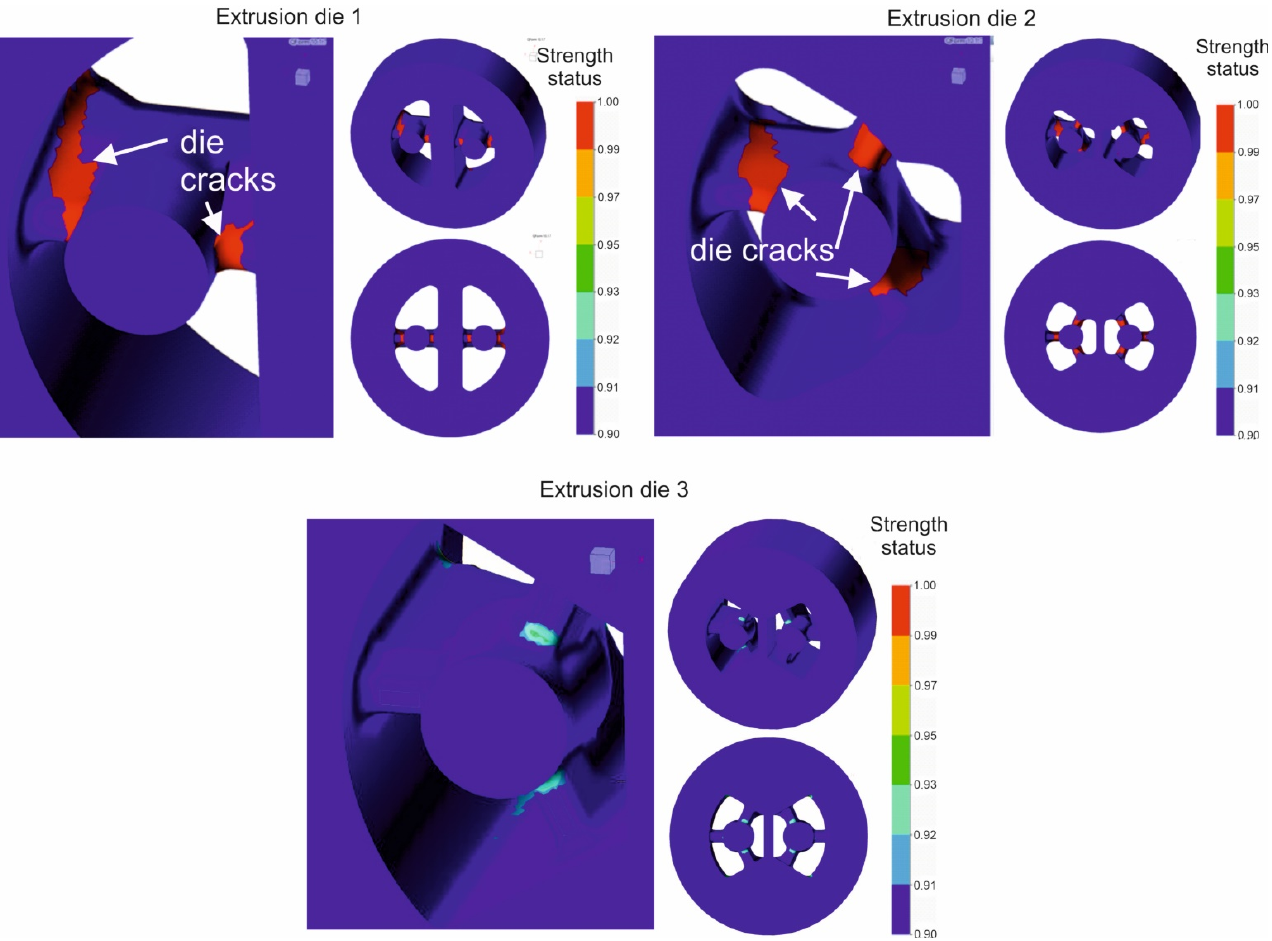
Figure 11. Distribution of strength status for the mandrel tops for different die geometry during extrusion of tubes of Ø50 × 2 mm from 7021 aluminium alloy.